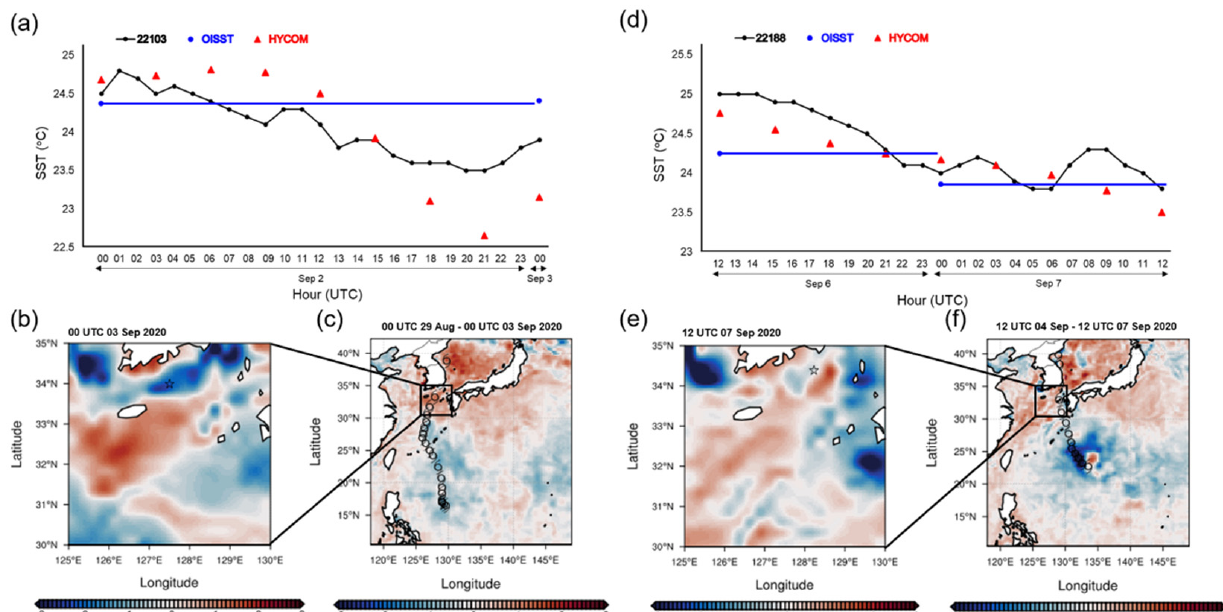
Figure 2. Time series of SST (°C) variations at the times when typhoons ( a ) Maysak and ( d ) Haishen passed near the Geomundo (34.0° N 127.5° E; 22103) and Tongyeong (34.4° N 128.2° E; 22188) stations. Blue: OISST; red: HYCOM; black: in-situ data. The OISST data are only provided in daily intervals and displayed SST values from OISST data were the same during the day regardless of the displayed time. Horizontal distribution of the difference in SST (°C, shading) between HYCOM and OISST data for typhoons ( b ) Maysak at 00 UTC 3 September 2020 and ( e ) Haishen at 12 UTC 7 September 2020. Star mark represents each buoy station, respectively. Horizontal distribution of average difference in SST (°C, shading) between HYCOM and OISST data for the entire forecast time for typhoons ( c ) Maysak and ( f ) Haishen. Typhoon marks represent the Regional Specialized Meteorological Center (RSMC) best tracks of typhoons Maysak and Haishen, respectively.